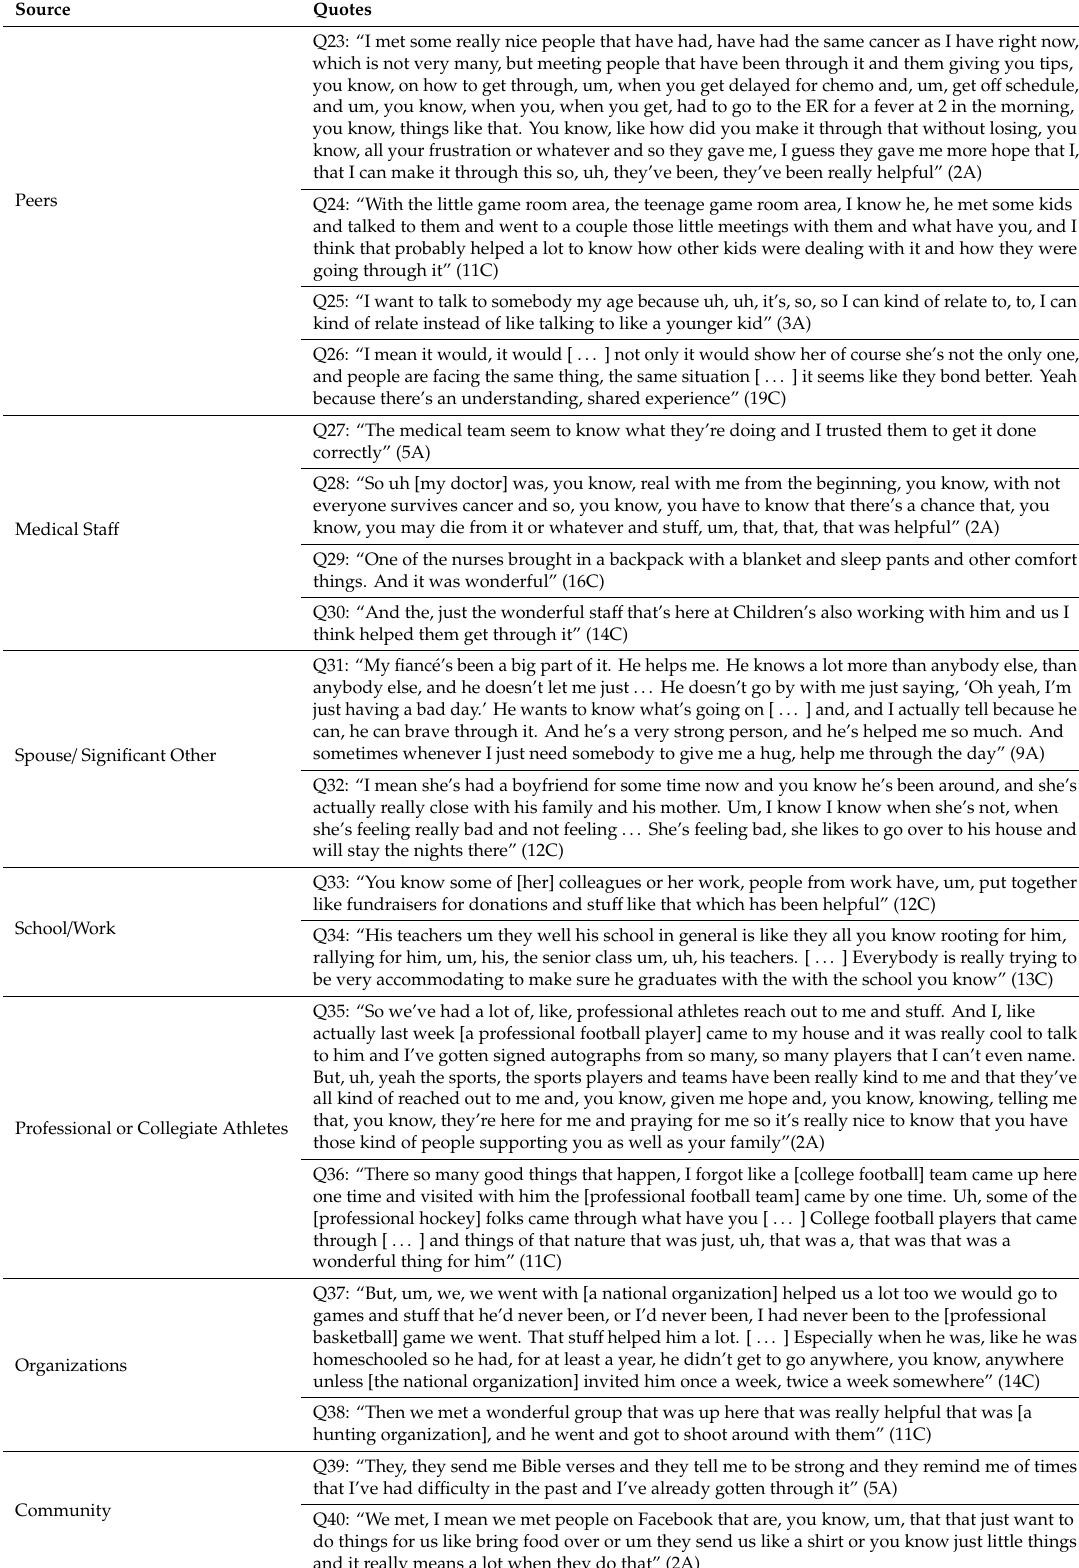
Table 5. Other social